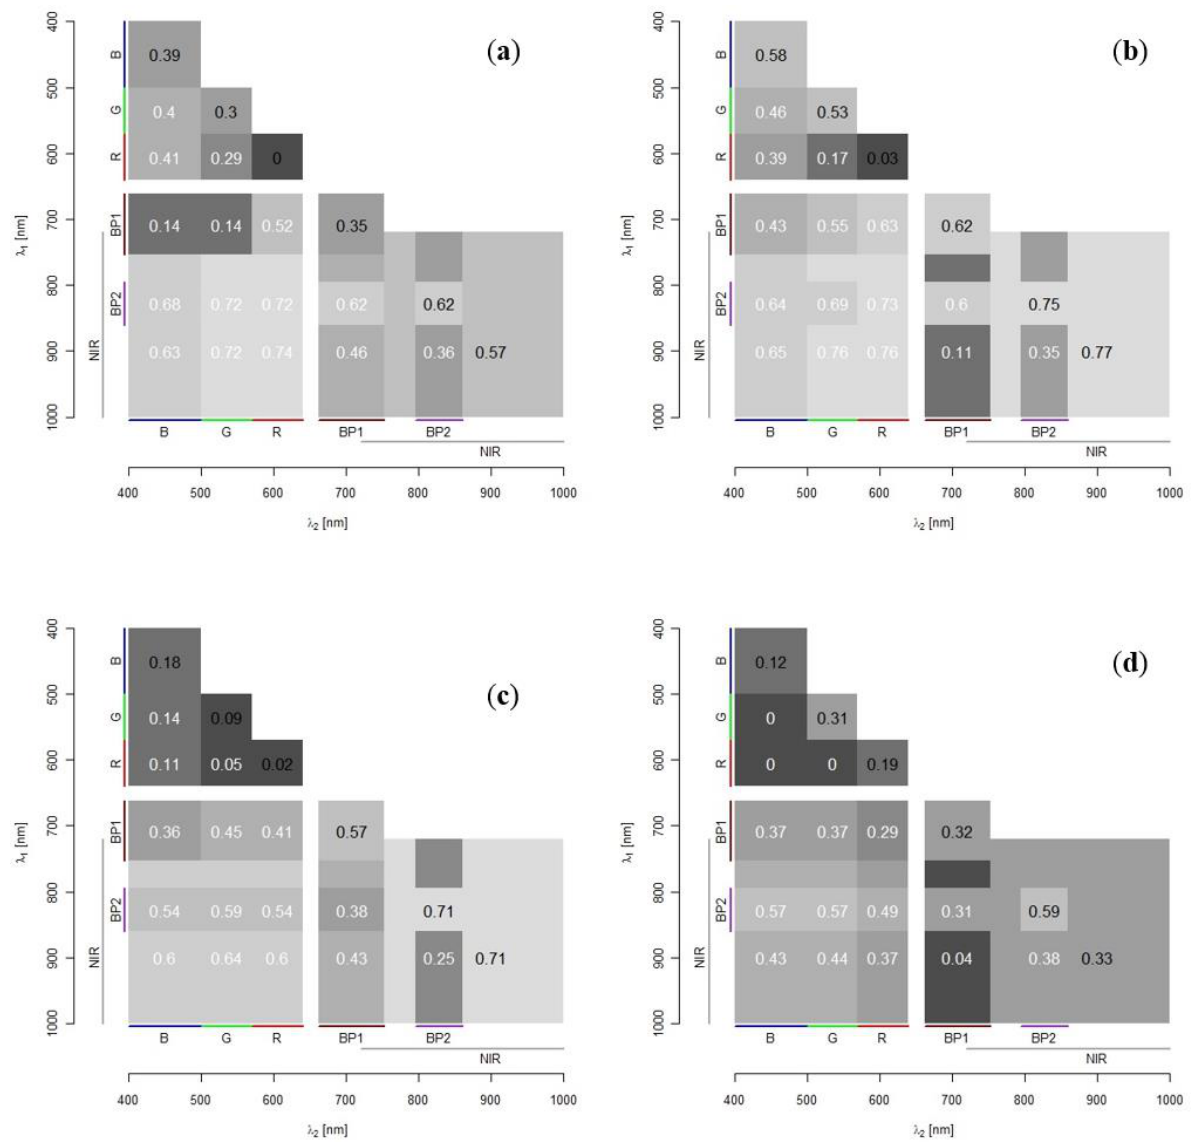
Figure 6. Optimal Band Ratio Analysis (OBRA) plots showing strength of image band ratio—depth associations for multi-spectral image composite bands and band ratios for ( a ) site 1a; ( b ) site 1b; ( c ) site 2; ( d ) site 3. Bottom half of each figure shows R² values of band ratios (white font). Diagonal values in black represent R² values for individual